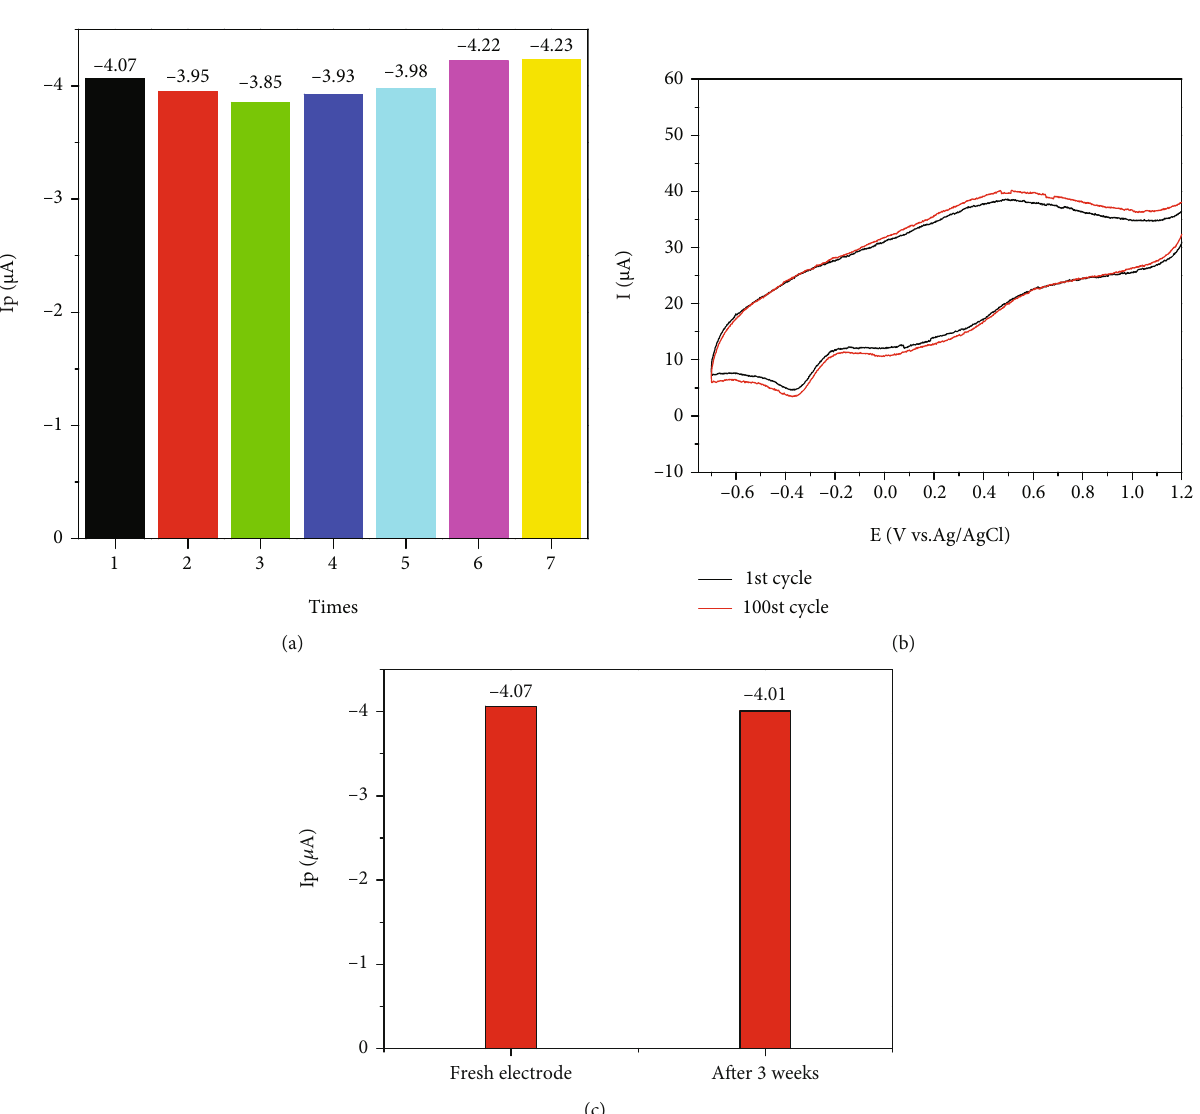
SO over 7 di ff erent MIL-53 (Fe)/GCEs. (b) The CVs of 2 4